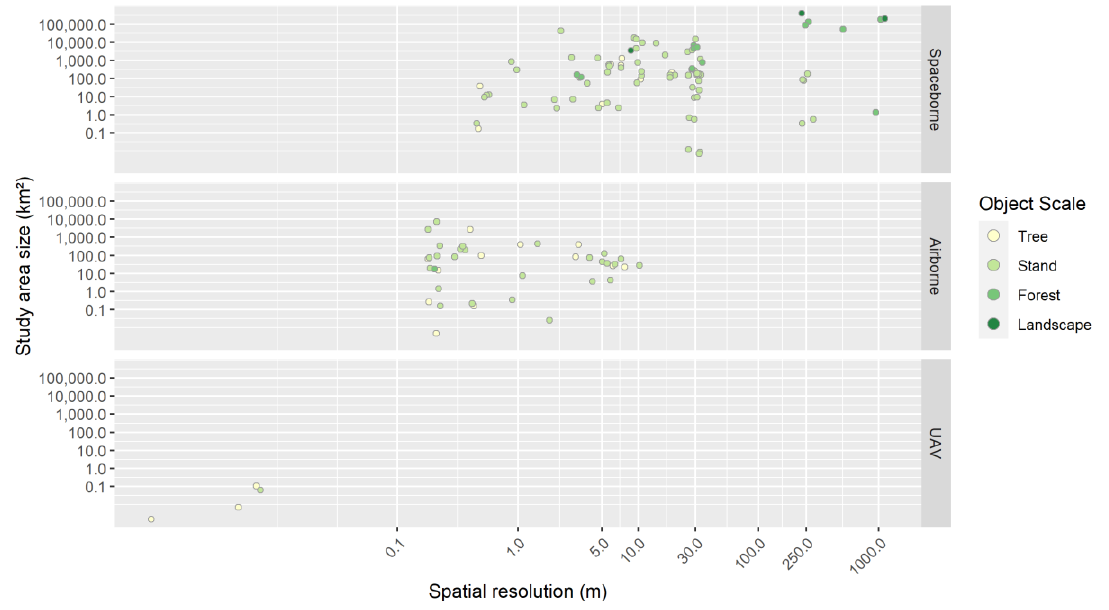
Figure 12. Spatial resolution in relation to platform type and size of study area by object scale investigated. Note that, for improved interpretability of the graphic, a jitter effect has been applied to separate overlapping points from each other, i.e., x-coordinates and y-coordinates are only approximate. Note that studies could be displayed multiple times, if they investigated multiple object scales or utilized multiple sensors.